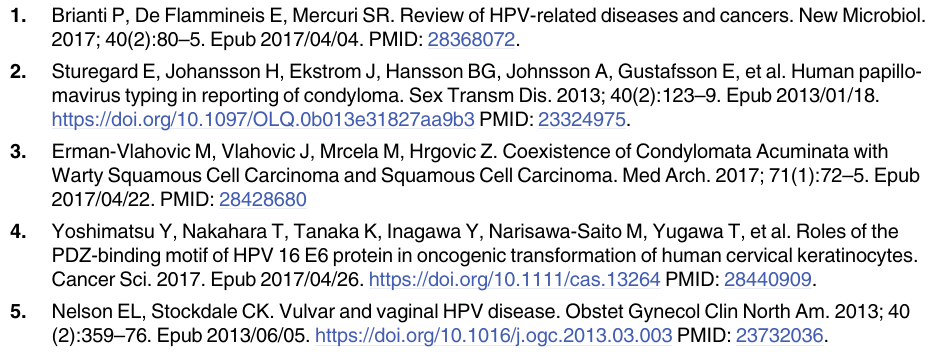
S7 Table. Patient´s characteristics of 27 fresh condyloma acuminata biopsies and normal